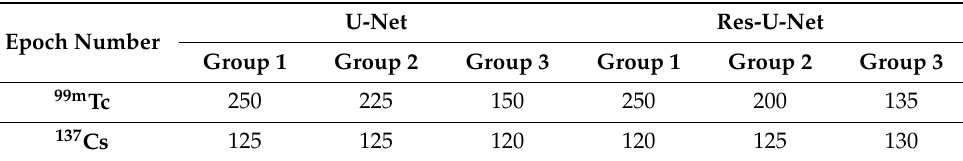
Table 1. Epoch numbers for training